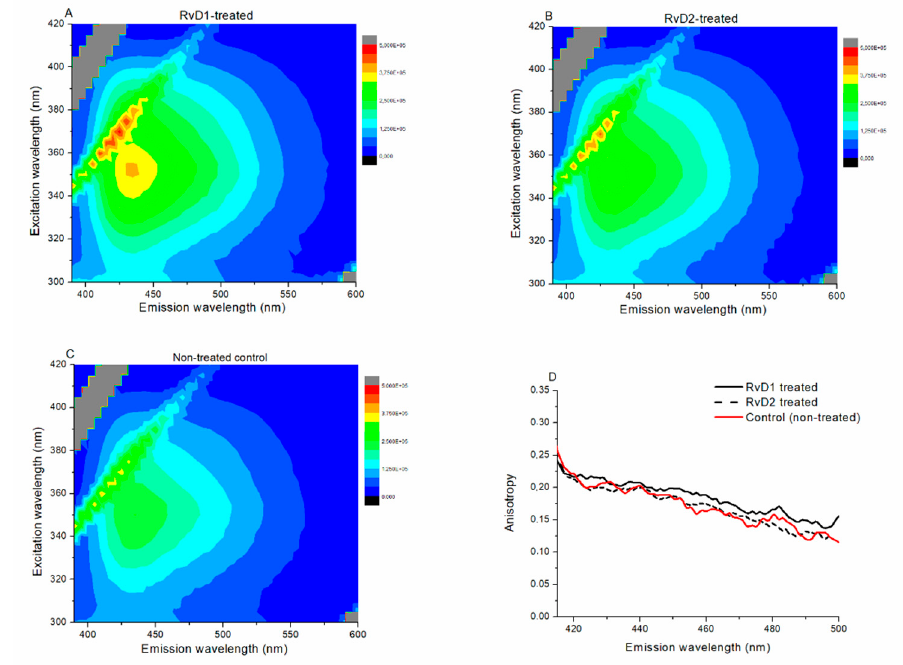
Figure 8. Excitation–emission matrices of RvD1-treated ( A ), RvD2-treated ( B ), and non-treated control ( C ) samples. ( D ): Emission anisotropy spectra of RvD1 (solid black), RvD2 (dashed black), and non-treated control (solid red) samples.